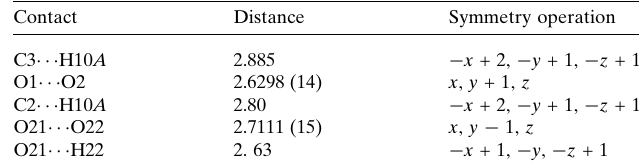
Table 2 Summary of short interatomic contacts (A˚